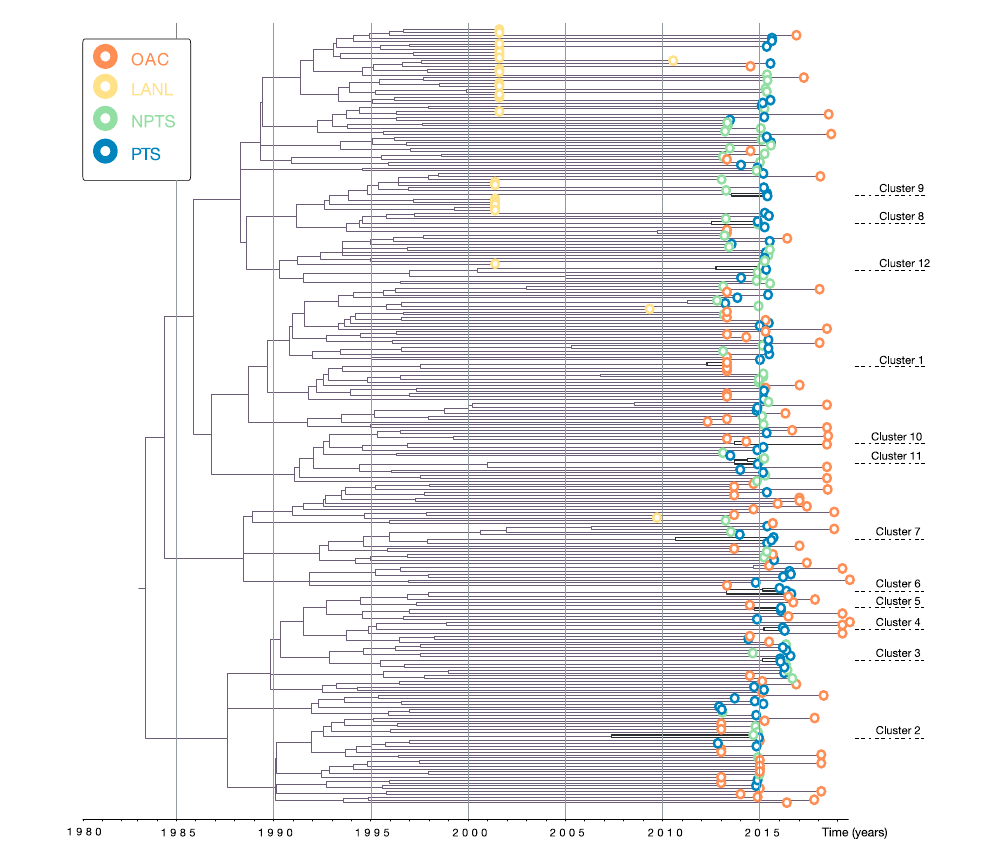
Figure 2. Molecular clock tree reconstructed from sequences in Odessa dataset. The thick black lines indicate the identified probable transmission clusters. OAC – sequences from the Odessa AIDS Centre patients, LANL – sequences from the Los Alamos National Laboratory HIV sequence database, NPTS - Non-participant TRIP samples, PTS - participant TRIP sample.